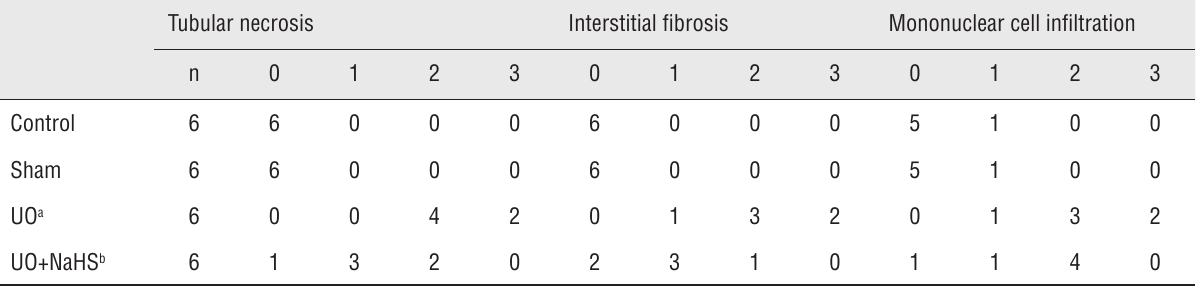
Table 3 - semiquantitative analysis of tubular necrosis, interstitial fibrosis, mononuclear cell infiltration in control, sham, uO, and uO+h s treated 2